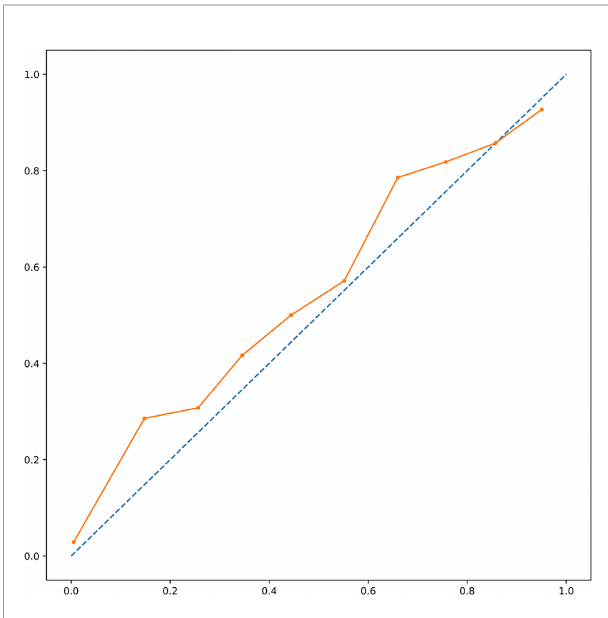
FIGURE 2 | Area under receiver operating characteristic curve of the algorithms. Left panel, eXtreme Gradient Boosting. Right Panel, Logistic